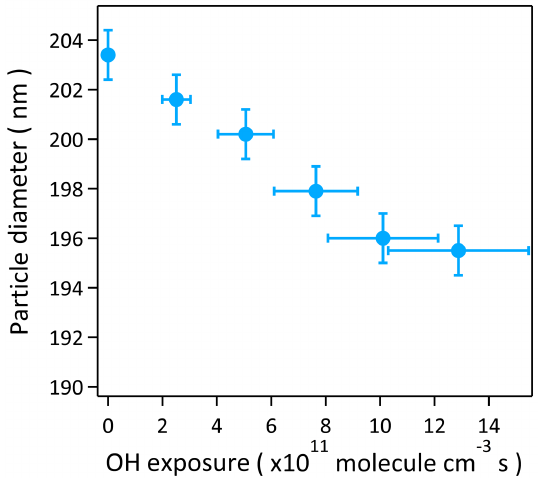
Figure 9. The surface-weighted particle diameter of sodium ethyl sulfate as a function of OH exposure during heterogeneous OH ox-